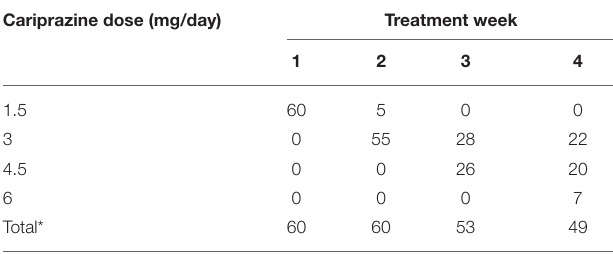
TABLE 1 | Socio-demographic characteristics of the study sample ( n = 60). Parameter